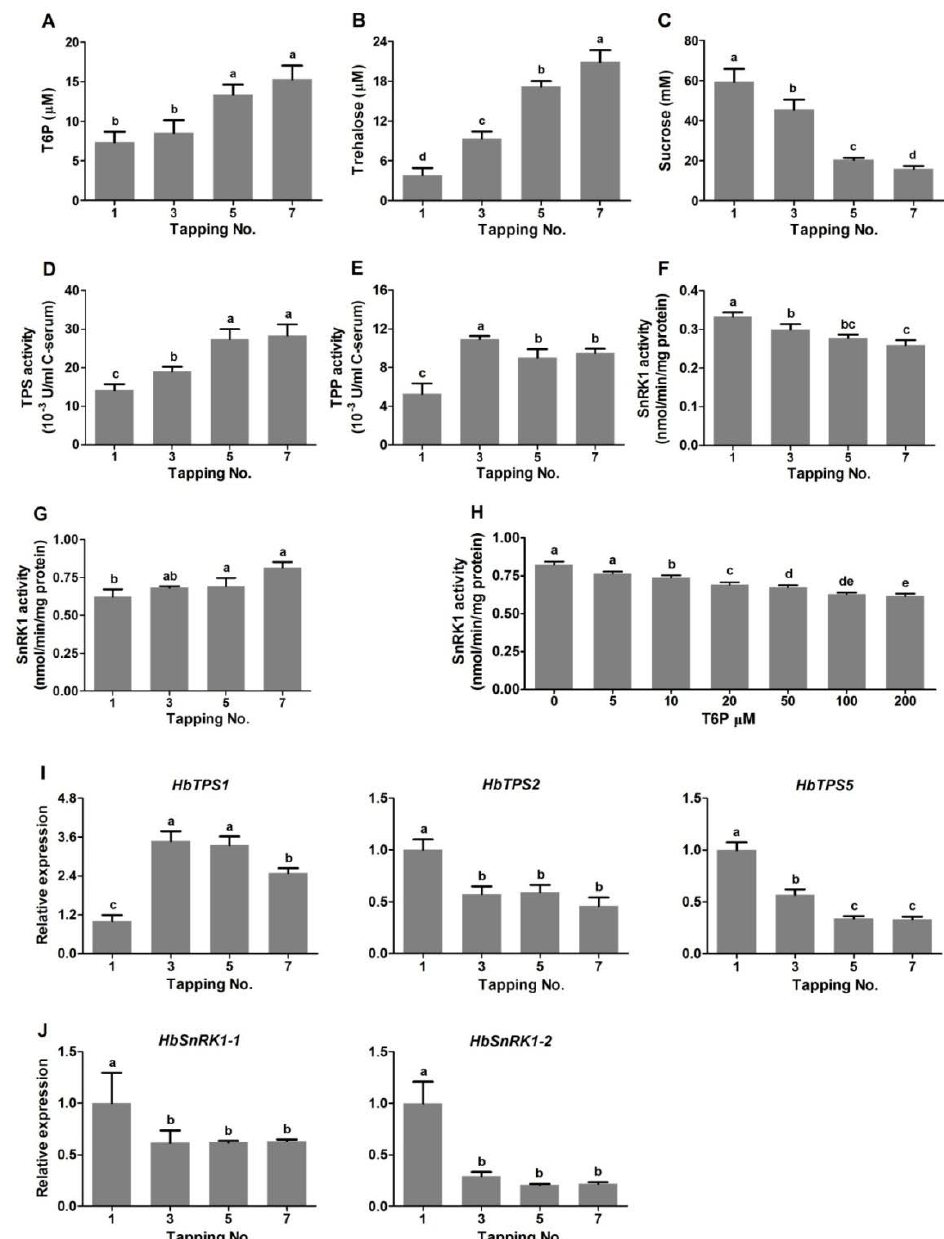
Figure 5. Metabolic, enzymatic, and transcriptional characterization of T6P-SnRK1 signaling components in Hevea latex during tapping. ( A – C ) Changes in T6P ( A ), trehalose ( B ), and sucrose ( C ) levels. ( D – G ) Changes in enzyme activities of TPS ( D ), TPP ( E ), and SnRK1 ( F ) in C-serum samples. SnRK1 activity in ultra-filtered C-serum ( G ) and dose effect of T6P on its activity ( H ). ( I ), Changes in expression of three HbTPS genes, HbTPS1 , 2 and 5, by qPCR. ( J ) Changes in expression of two HbSnRK1 genes, HbSnRK1-1 and 1-2, by qPCR. Values are means ± standard deviations of three biological replicates. Different letters indicate significant differences (Student’s t -test was performed using the software embedded in Excel 2019, p ≤ 0.05).